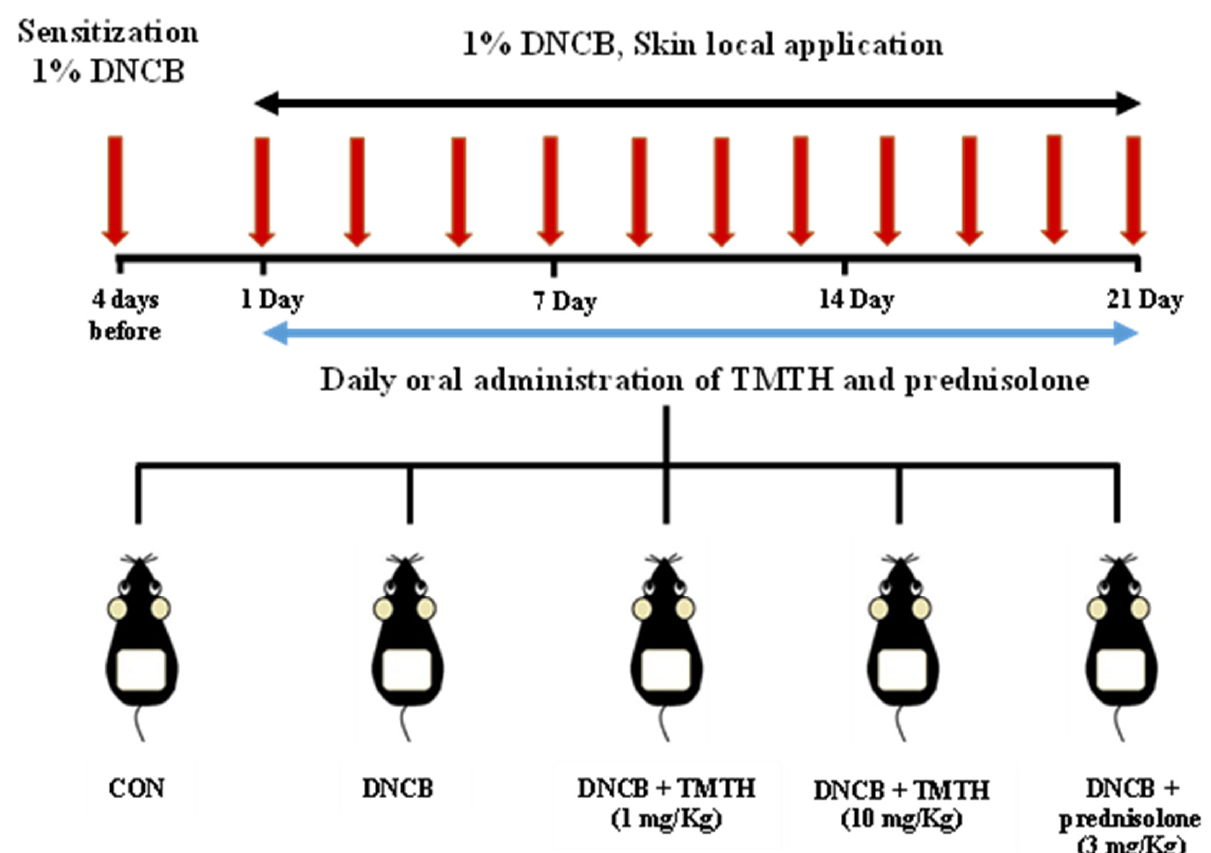
Figure 1. Sensitization of C57BL/6 mice was performed using 1% 1-chloro-2,4-dinitrobenzene (DNCB) four days before oral administration and on day 1. Subsequently, mice were challenged with 1% DNCB at two-day intervals for three weeks. Tenebrio molitor trypsin hydrolysate (TMTH; 1 and 10 mg/kg) and prednisolone (3 mg/kg) were orally administered daily for three weeks to treat atopic dermatitis (AD)-like lesions.